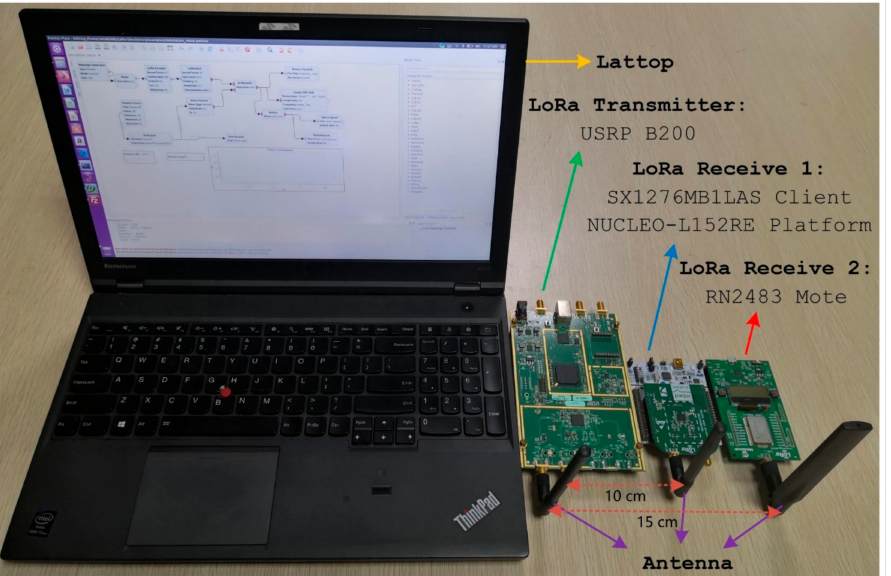
Figure 4. Our own developed LoRa transceiver and two commercial LoRa transceivers. From left to right: Lattop, a transceiver developed based on USRP B200 software radios; the Semtech SX1276 LoRa ™ mbed ™ Enabled Shields; and the Microchip Technology RN2483 LoRa ® Mote. The other two commercial transceivers are the Semtech SX1276 LoRa ™ mbed ™ Enabled Shields and the RN2483 Mote from Microchip. Semtech SX1276 LoRa ™ mbed ™ Enabled Shields combine the Semtech SX1276 Low Power Long Range Transceiver with the ARM mbed ™ Internet of Things (IoT) Device Platform. The mbed shields plug into mbed microcontroller development platforms from STMicroelectronics, NXP, and others. The SX1276MB1MAS is designed around ISM frequency bands 433 and 868 MHz for use in China and Europe. SX1276MB1MAS can operate in several frequency bands using two different RF ports: PA_LF and PA_HF. PA_LF covers the lower frequency band (band below 525 MHz), while PA_HF covers the higher frequency band (band above 860 MHz). The operating frequency band is controlled by register settings to produce the following values: 434, 470, 490, 868, and 915 MHz. However, changing the frequency band also requires the corresponding impedance matching in the RF front end to be of SX1276MB1MAS can reach 14 dBm, and the maximum power can reach 20 dBm by an LoRaWAN Class A terminal device based on the RN2483 LoRa module. RN2483 Mote